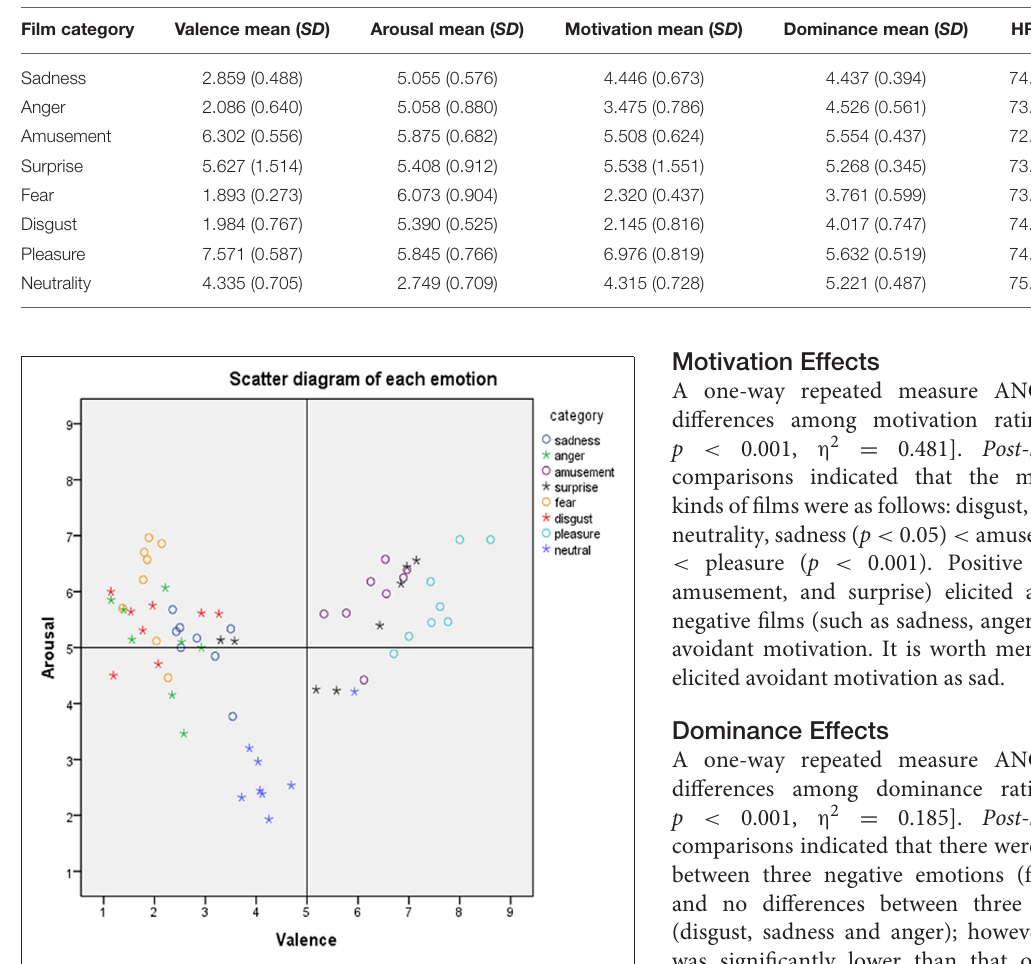
FIGURE 1 | The distribution of the film clips in the affective space (mean values for valence on the horizontal axis and arousal on the vertical axis).